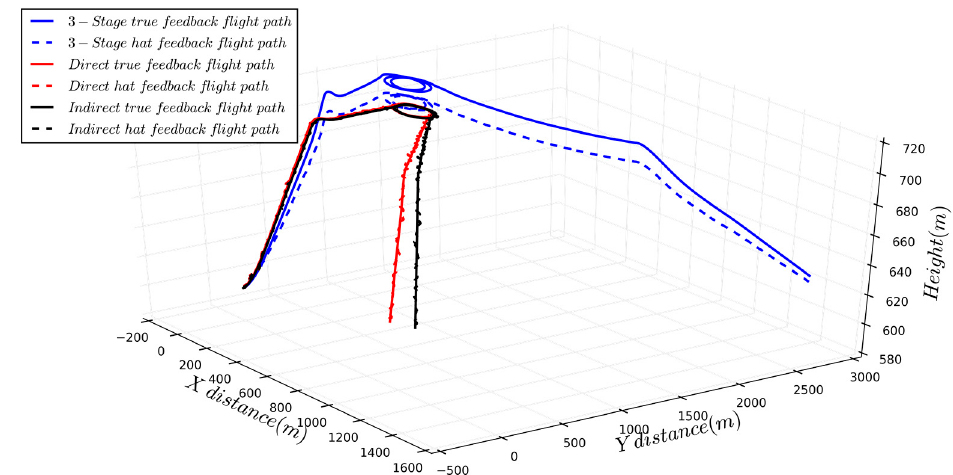
Figure 12. Flight trajectory comparison of different state estimation algorithms.